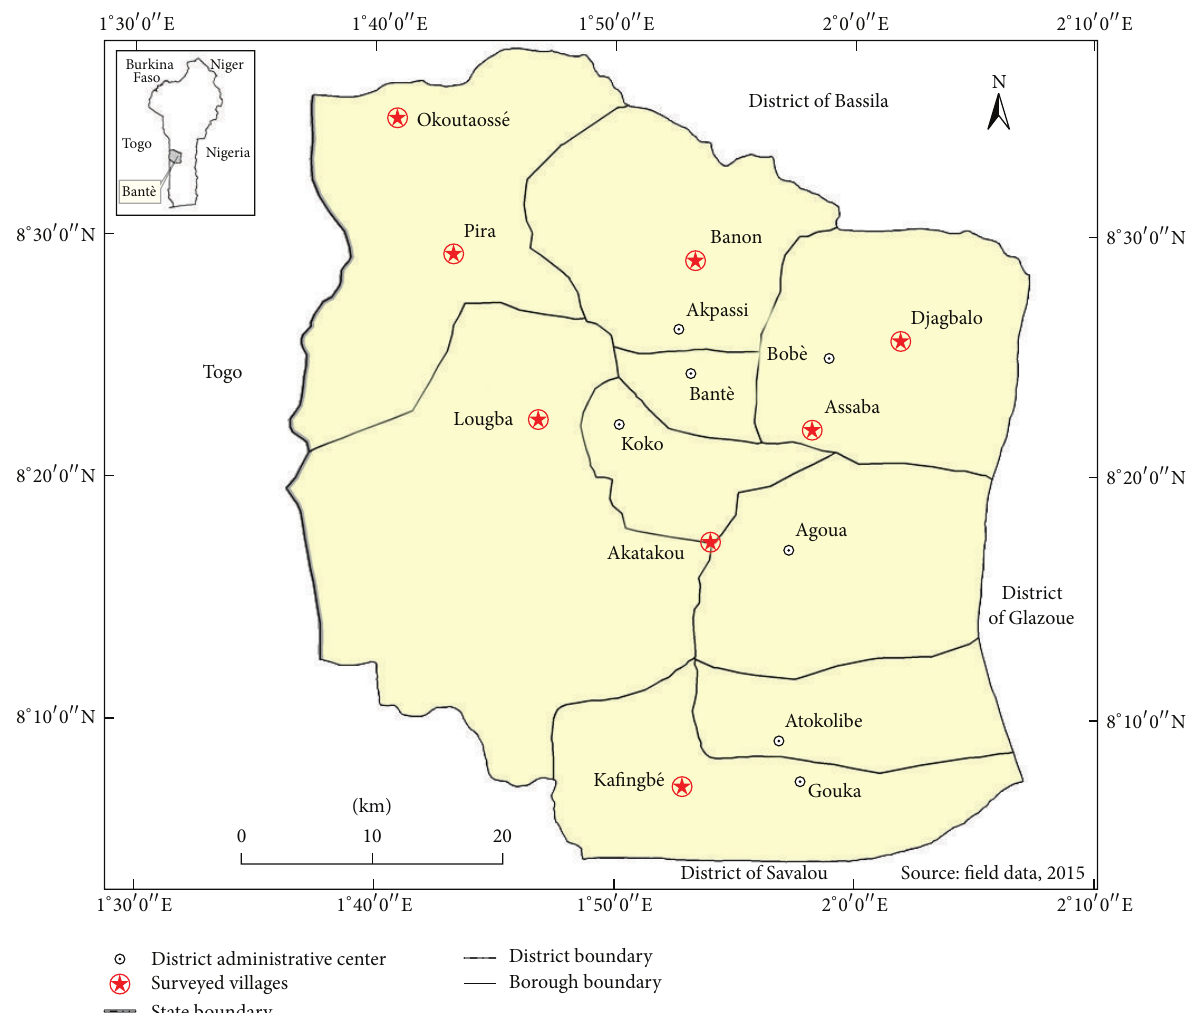
Figure 1: Map of the study area showing the villages